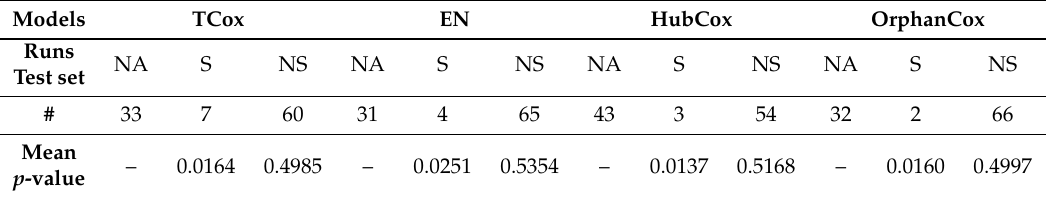
Figure 2. p -values obtained in the separation of high- and low-risk survival curves based on the genes selected by TCox models generated with transformations of w using colorectal RNA-seq data, tested over different α values. Table 1. Results from 100 runs of training and test sets in all survival models analyzed using α = 0.1. S—statistically significant runs ( p -value < 0.05); NS—non-statistically significant runs; #—number of